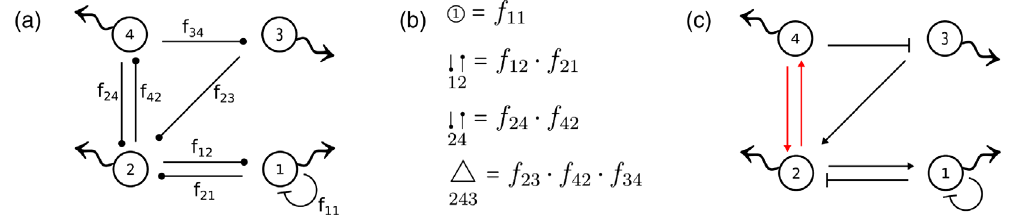
FIG. 9. (a) A minimal four-node topology. (b) Cycles contained in the topology and their weight in terms of the kinetic terms. (c) Turing network based on the example topology. It becomes a type III network just by assuming that node 4 is